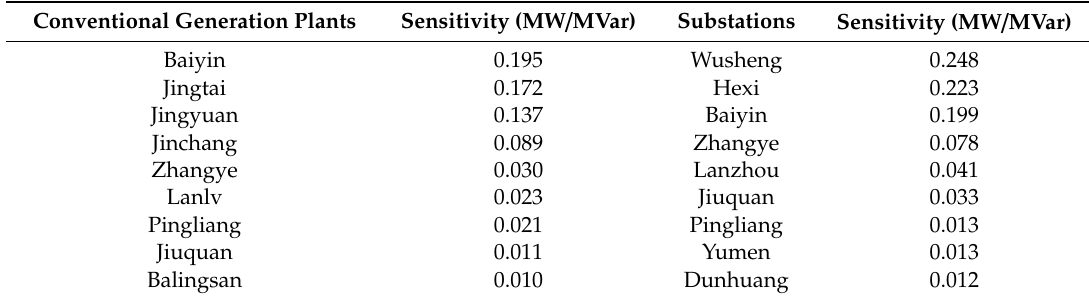
Table 2. Sensitivity between the transient stability total transfer capability (TSTTC) and the reactive power of each conventional generation plant and substation in the first reactive power adjustment (sorted by